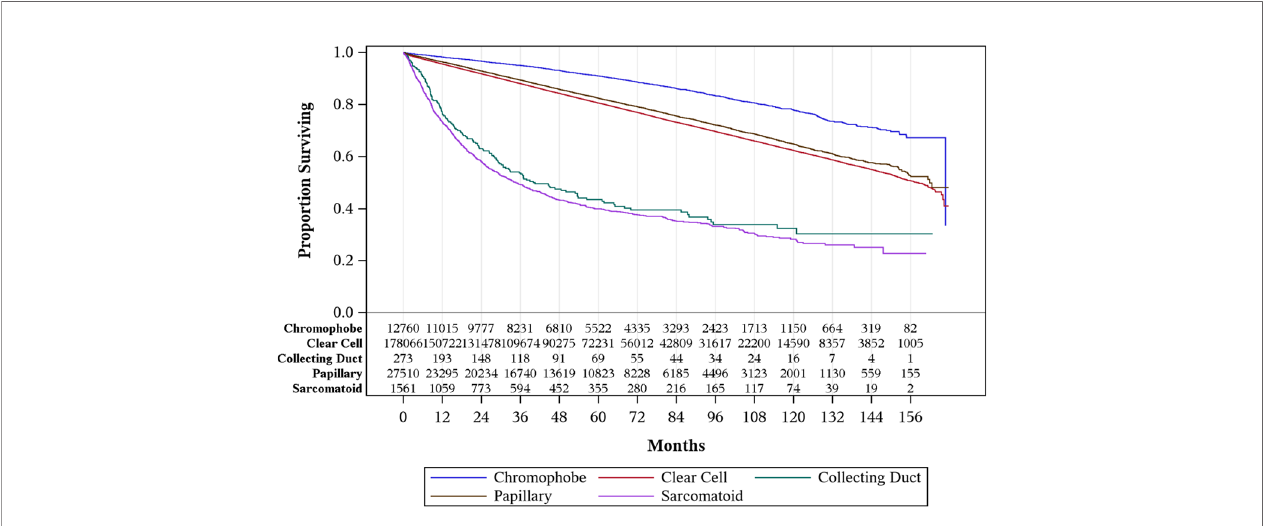
FIGURE 1 | Overall survival by histology for stages I – III renal cell carcinoma